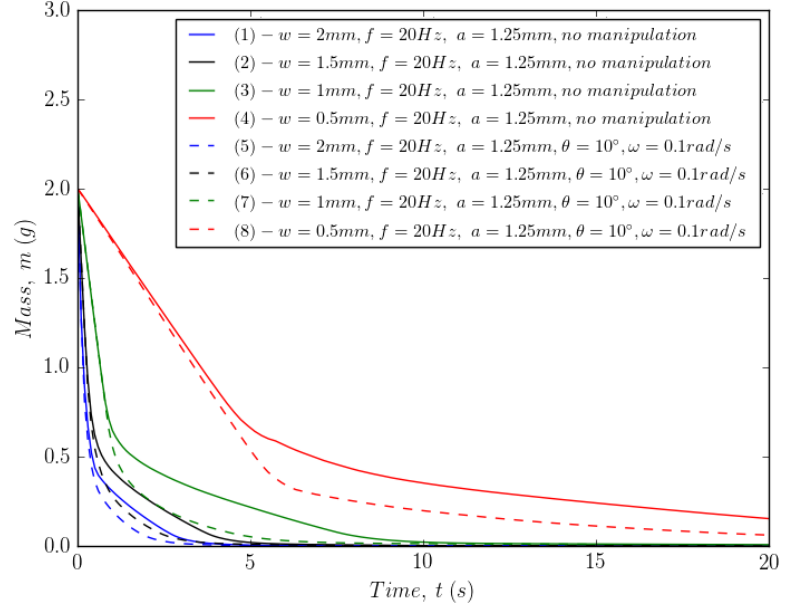
Figure 10. Effect of manipulation and wall-normal